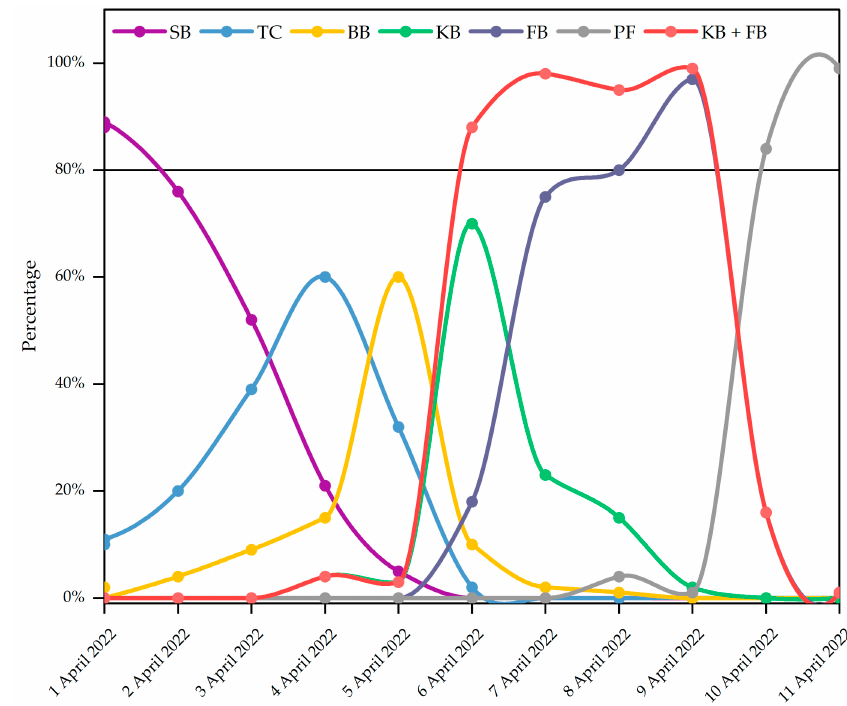
Figure 13. Peak blooming day finding.